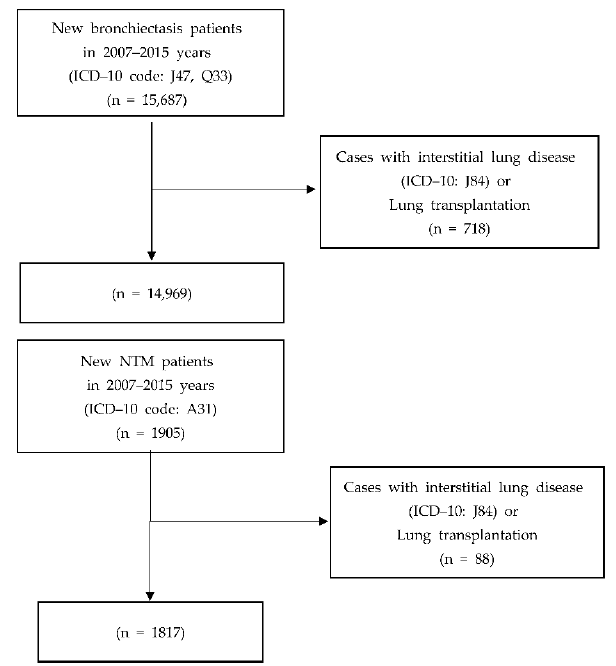
Figure 1. Flowchart for the study population selection.